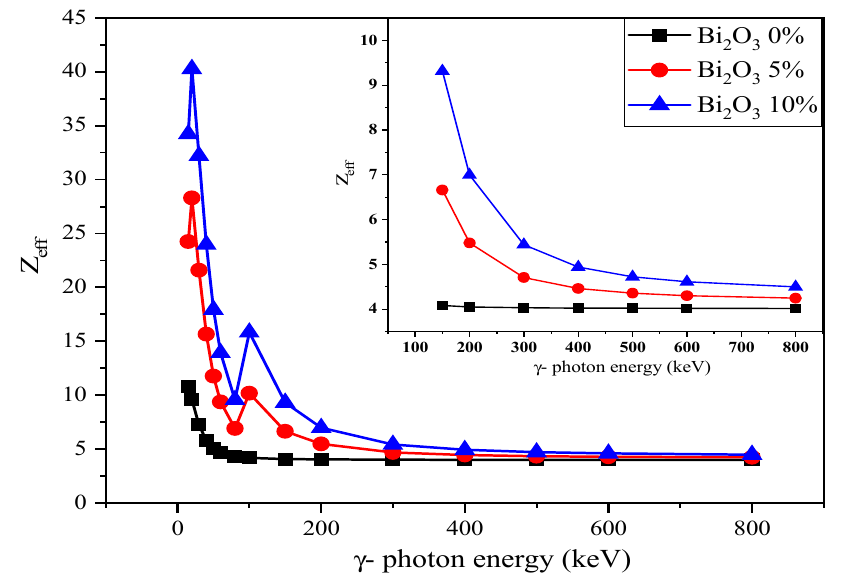
Figure 8. Variation in the effective atomic number (Z eff ) of the synthesized polyepoxide-reinforced Bi 2 O 3 composites versus the emitted γ -photon energy.